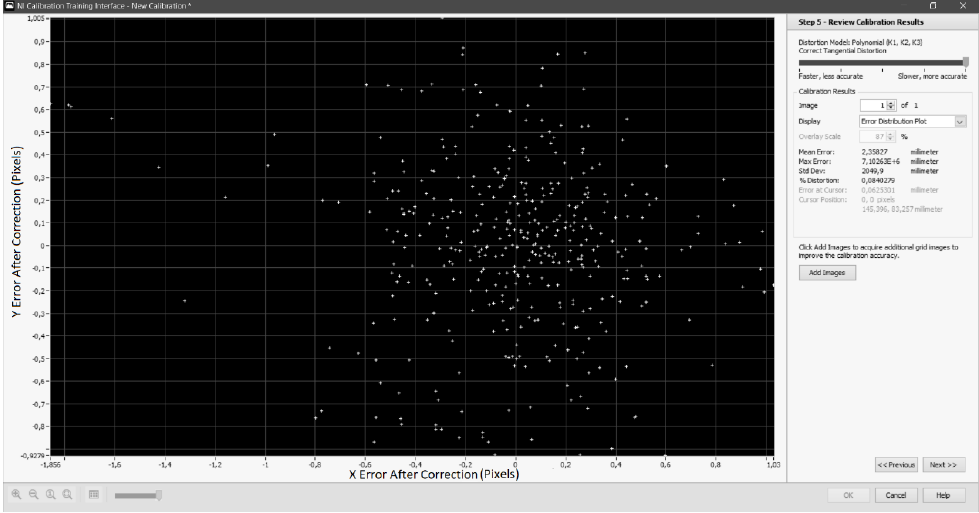
Figure 7. Map of distorted points in calibration process.